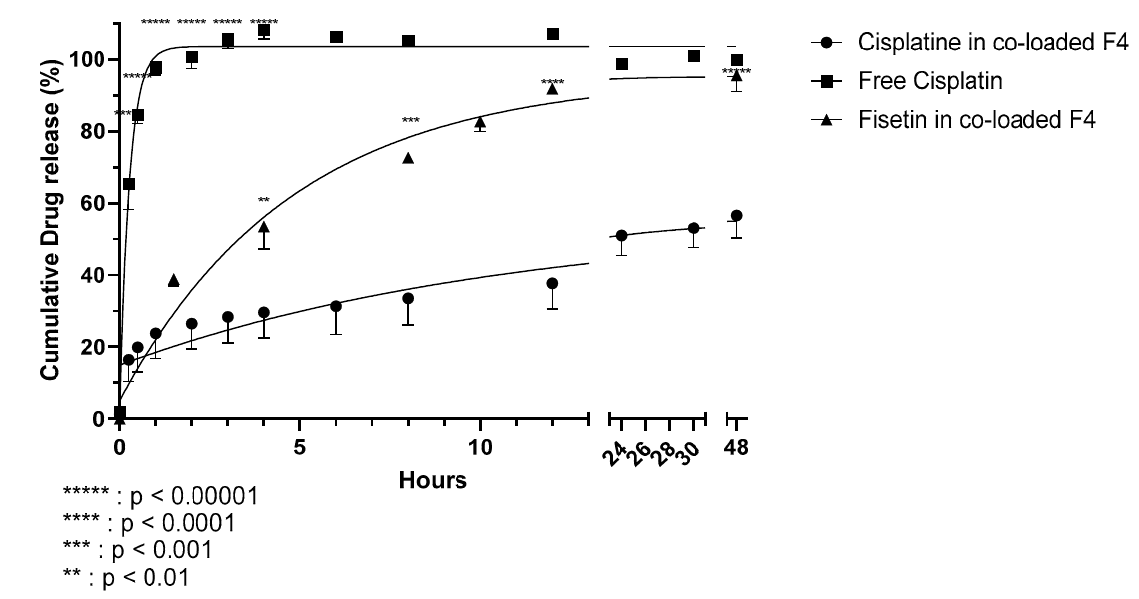
Figure 4. In vitro release of cisplatin and fisetin by formulation 4 co-encapsulating cisplatin and fisetin in PBS. Liposomal cisplatin (circle), free cisplatin (square) and liposomal fisetin (triangle) (mean ± SD, n = 3).